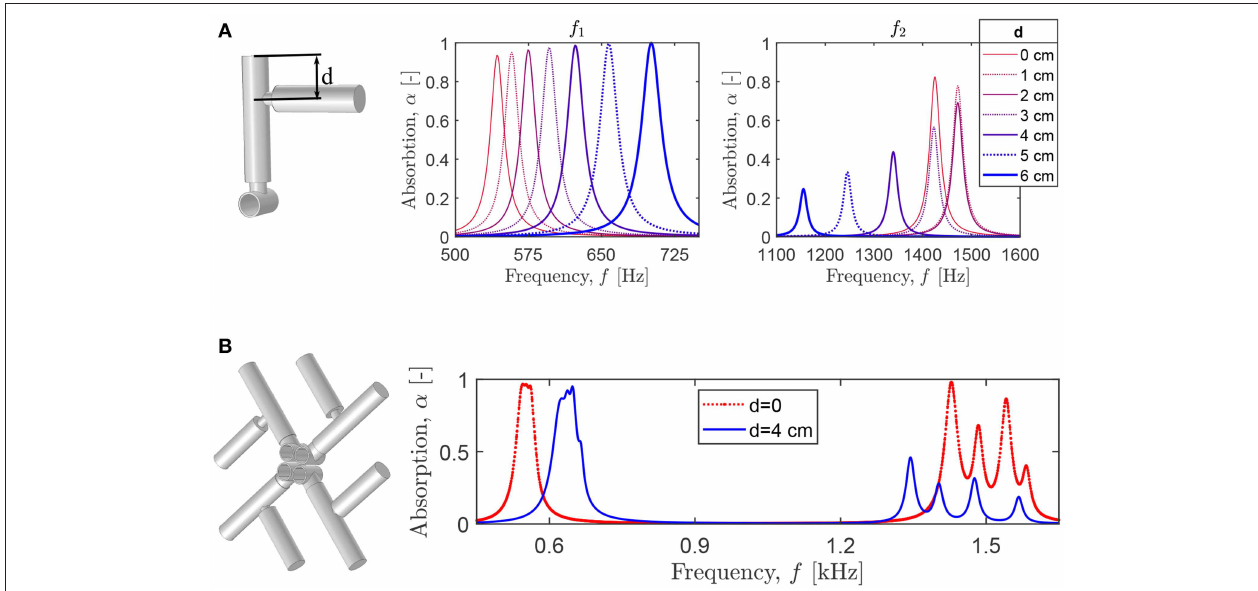
FIGURE 10 | (A) The absorption peaks for the varying position of the upper part of the coupled HR relative to the lower part. (B) The absorption coefficient of a